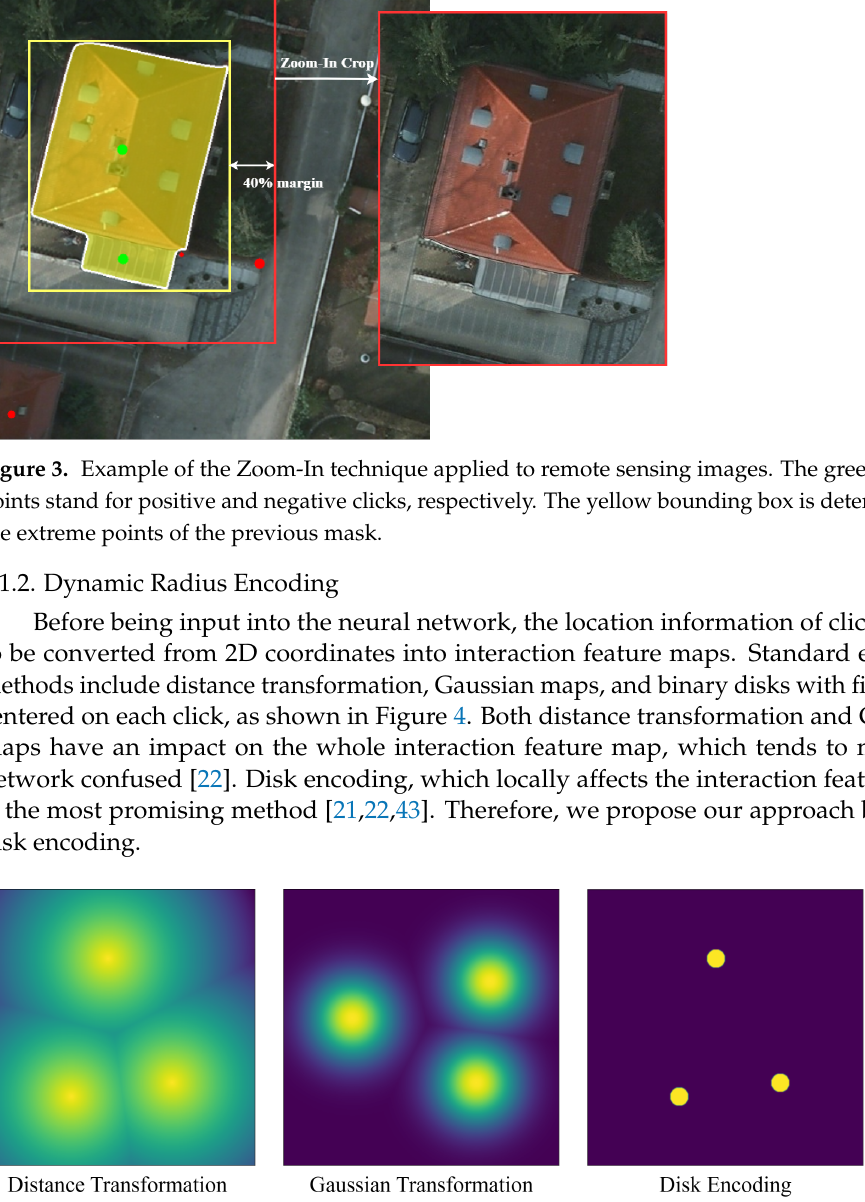
Figure 4. Visualization of three common click-encoding methods. Distance transformation calculates the Euclidean distance between pixels and clicks, while Gaussian transformation makes a Gaussian distribution centered on each click. Disk encoding uses a binary disk with a defined